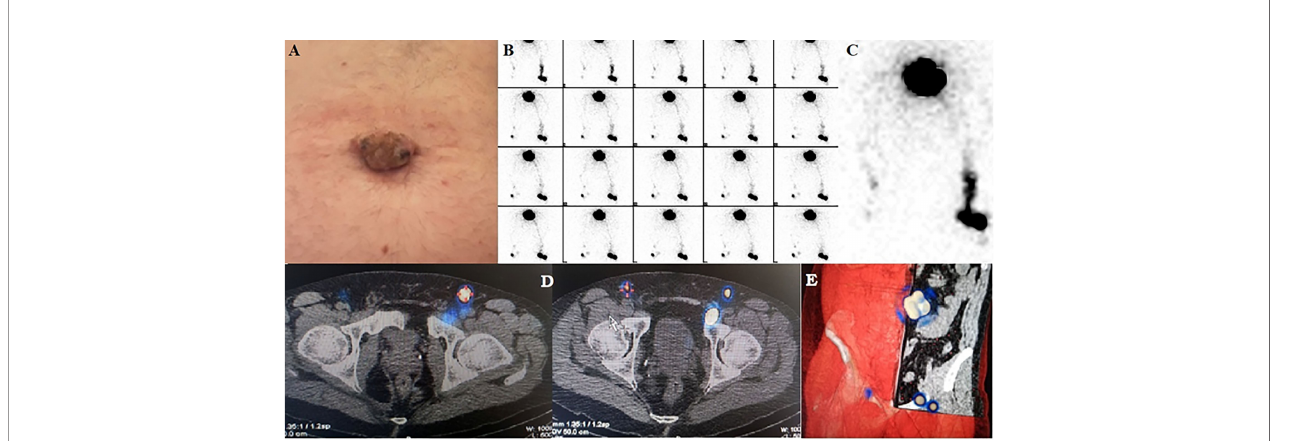
FIGURE 1 | (A) Umbilical melanoma (B) Dynamic sequential images showing three lymphatic collectors departing from peritumoral injection sites (C) Detail showing direct drainage from the injection site to the left external iliac lymph node. (D) Fused axial SPECT-CT sections differentiate inguinal sentinel nodes from an external iliac sentinel node on the left. (E) Volume rendering SPECT-CT of the true sentinel nodes used for guiding